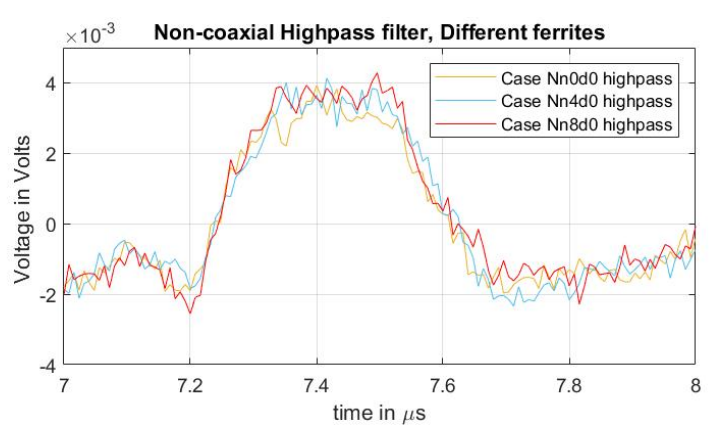
Figure 9. Acoustic magnitude comparison between the different cases of adding external inductance to the ground path.